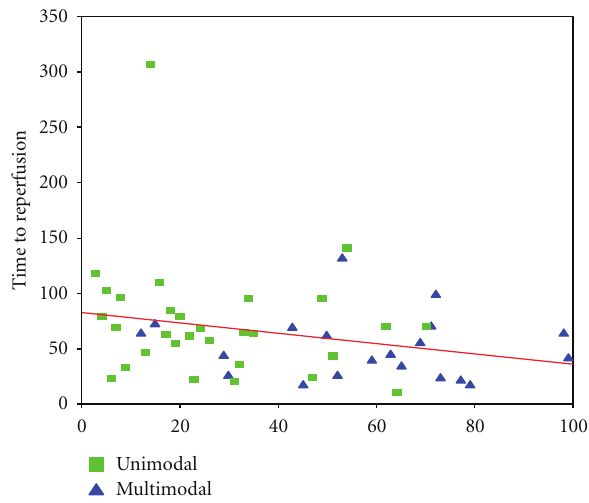
Figure 7: The scatter plot visualizes 2 interesting observations. Throughout the observation period, we used increasingly a mul- timodal recanalization strategy with simultaneously decreasing reperfusion